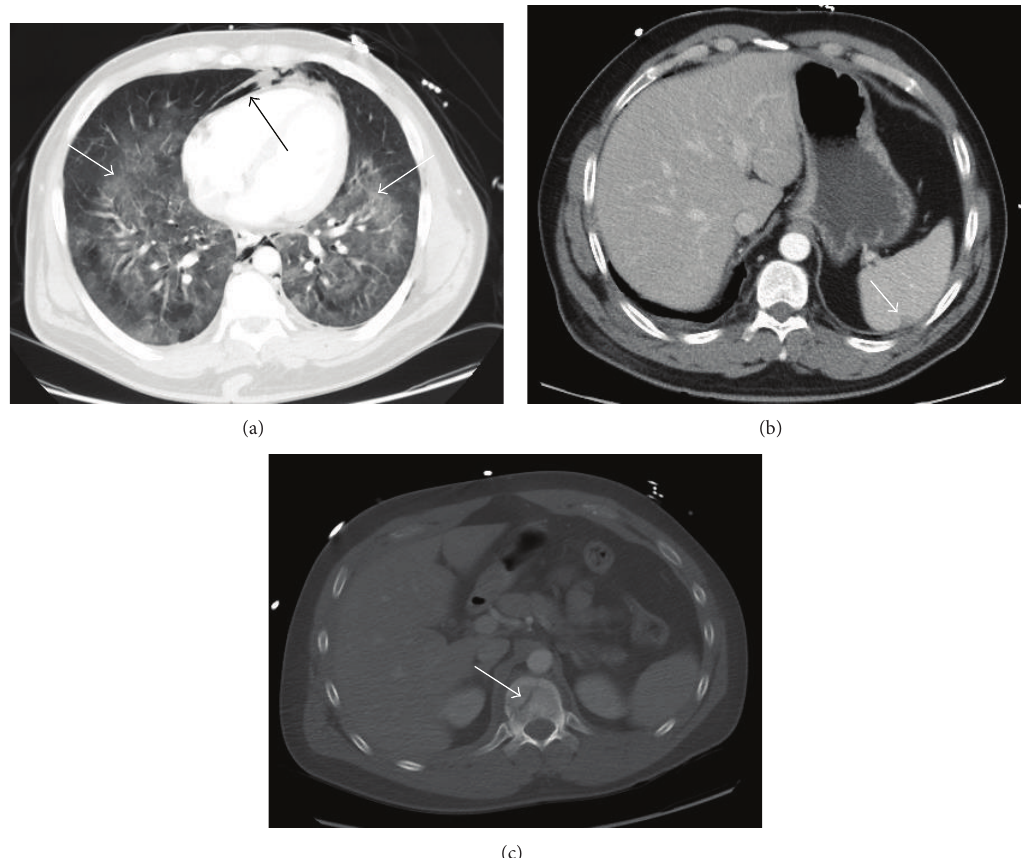
Figure 4: Image acquisition with the IR 40 protocol. In (a) the white arrows mark the bipulmonary contusions. The black arrow tags the mediastinal emphysema. In (b) the white arrow marks a subtle splenic laceration in the dorsal pole similar to the splenic lesion in Figure 3(b). Finding of a vertebral body fracture in (c) after a motorcycle accident. No accompanying lesion of the pancreas could be found.